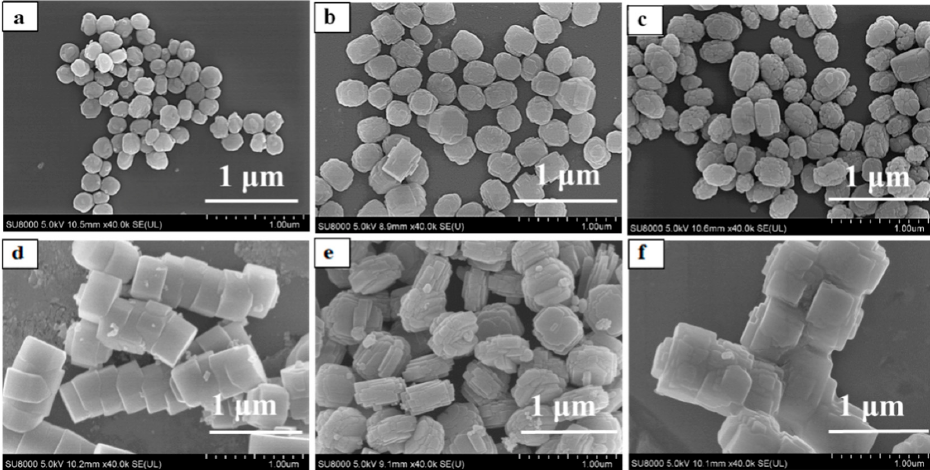
Table 1. Textural properties of Silicalite-1/TS-1 zeolites.